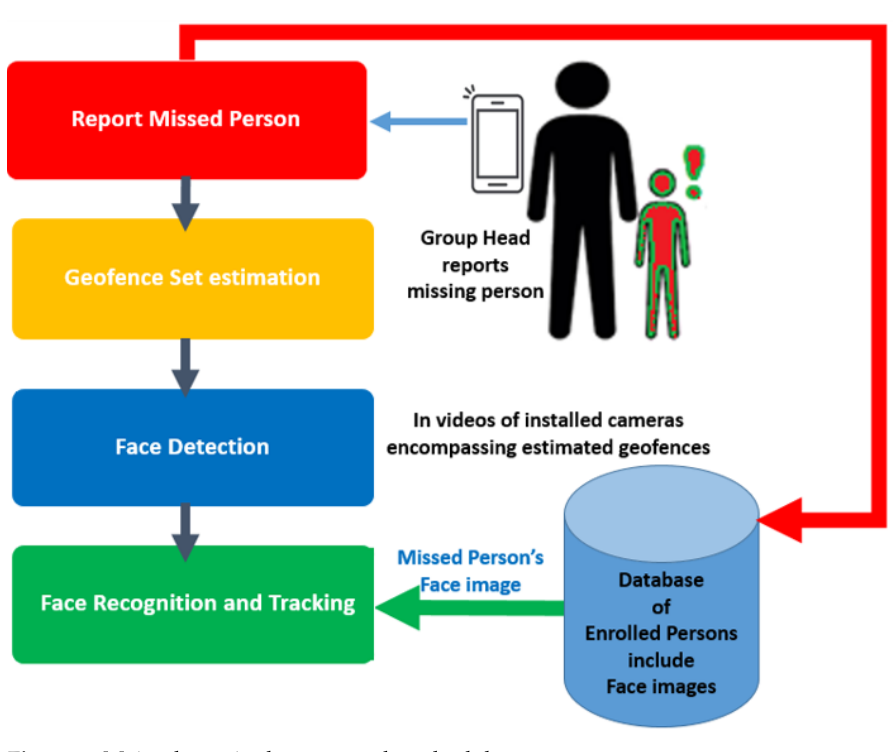
Figure 1. Main phases in the proposed methodology.